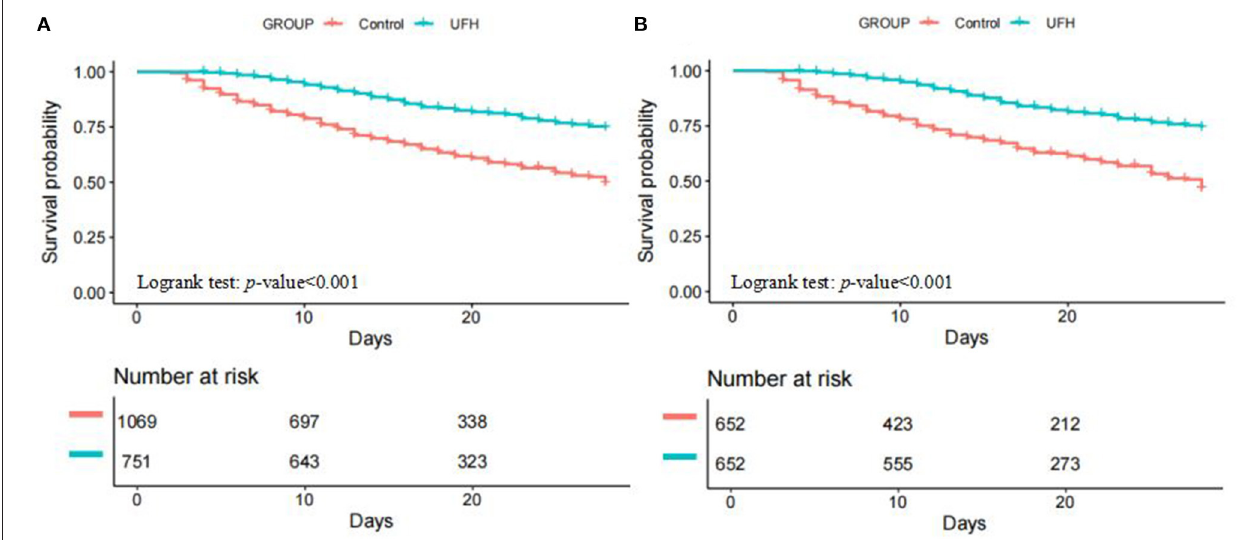
FIGURE 2 | Kaplan–Meier estimates of cumulative probabilities of 28-day survival for SIC patients in UFH group and control group. (A) pre-matched cohort; (B) post-matched cohort. SIC, sepsis-induced coagulopathy